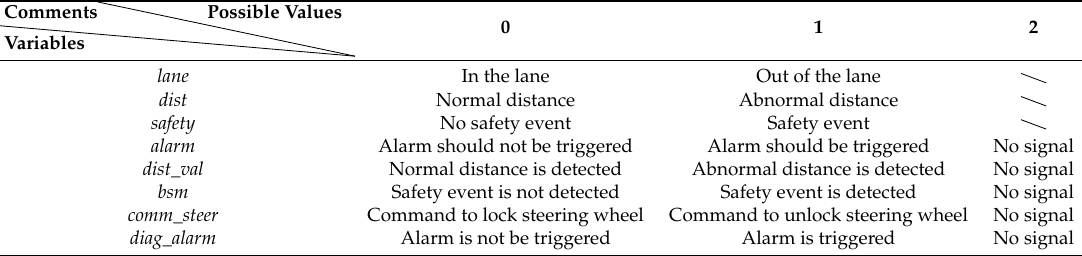
Figure 8. Collision warning system based on distributed EEA. Table 4. Description of some of the variables involved in the